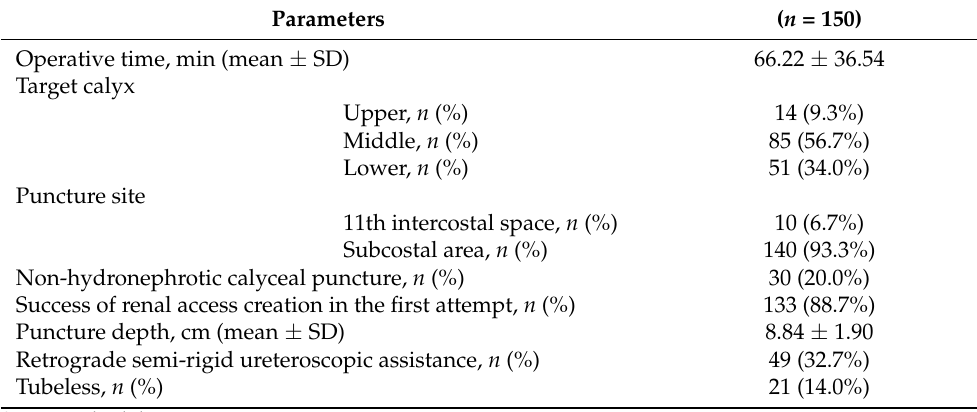
Table 2. Intraoperative